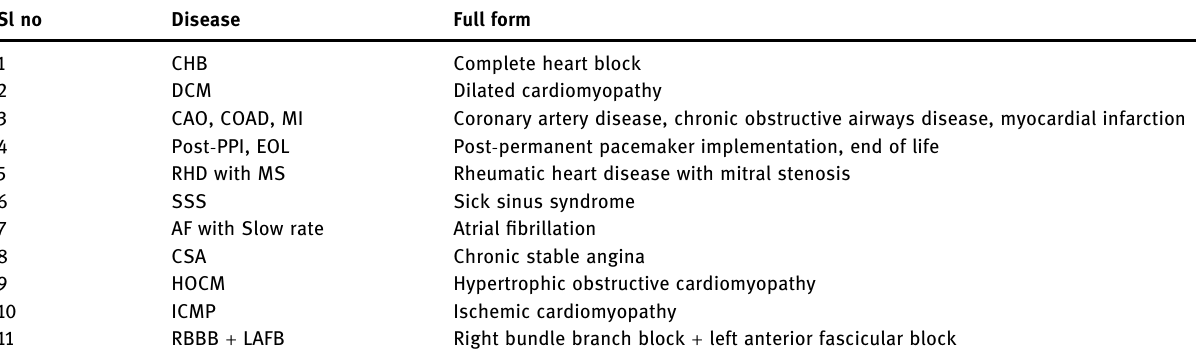
Table 6: The ANN - predicted heart disease checklist Sl no Disease